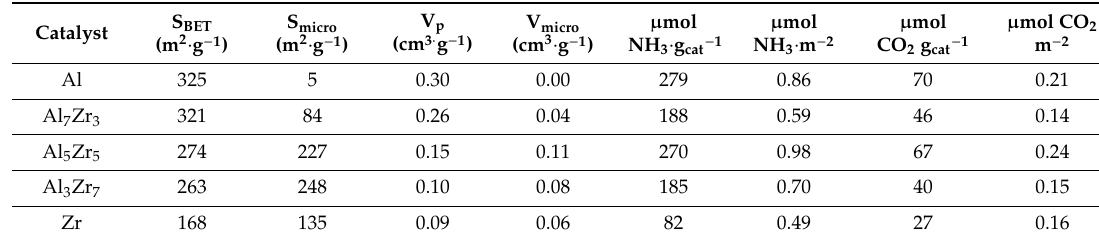
Figure 2. ( A ) N 2 adsorption–desorption isotherms at − 196 ◦ C and ( B ) pore size distributions of Al, Zr, and Al x Zr y catalysts. Table 1. Textural and acid-base properties of